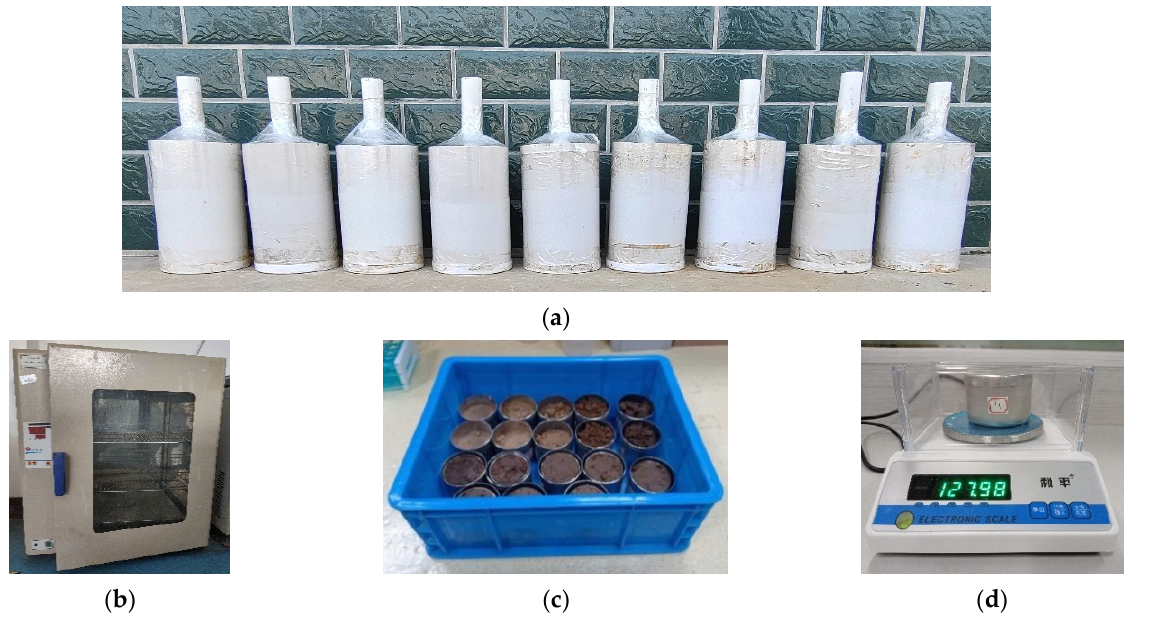
Figure 16. Test plot of moisture measurement model construction. ( a ) Soil samples with different gradient moisture content. ( b ) Hot drum drying box; ( c ) ring knife used to take soil; ( d ) weighing the soil before and after drying.